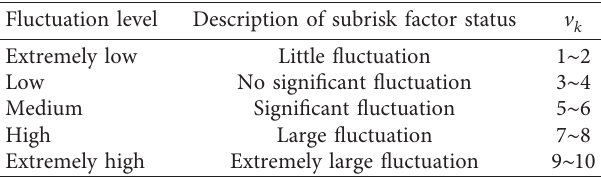
Table 3: Classification of fluctuation level of subrisk factors.